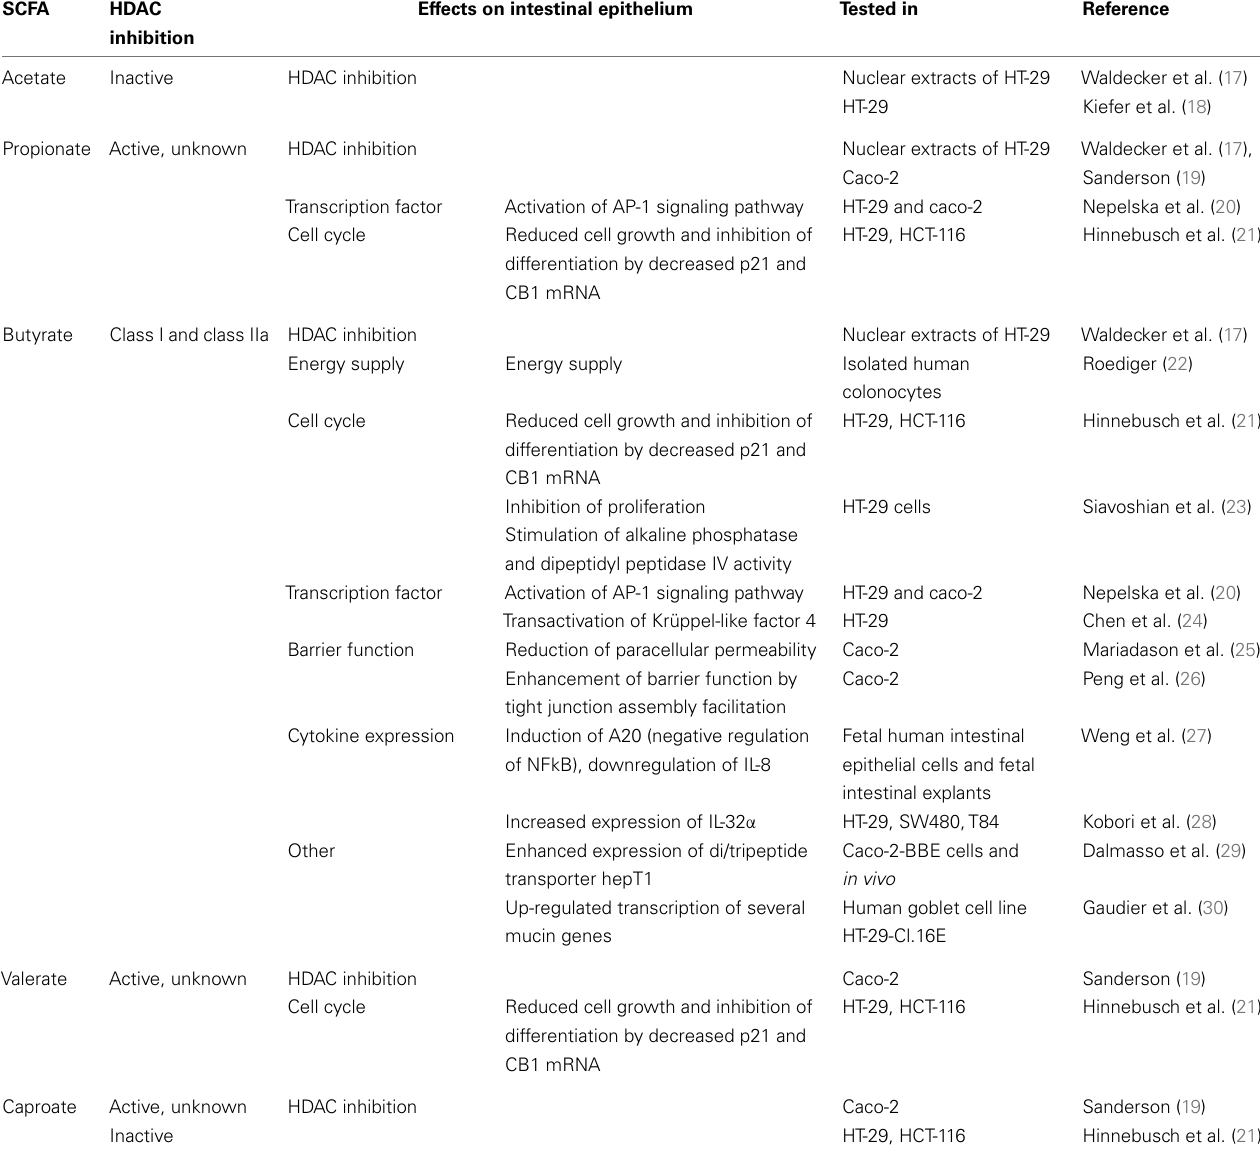
Table 1 | Examples of SCFA-induced effects on intestinal